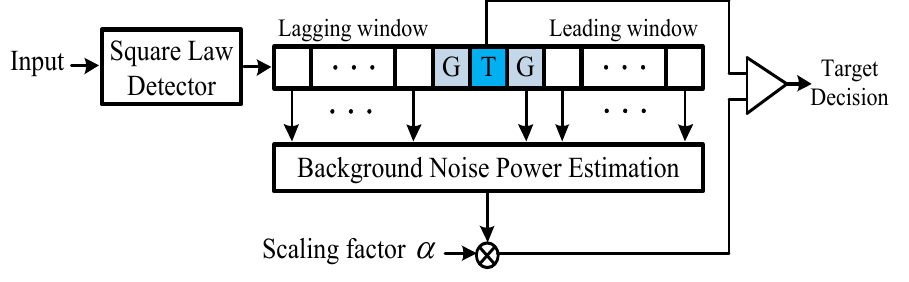
Figure 1. Block diagram of CFAR